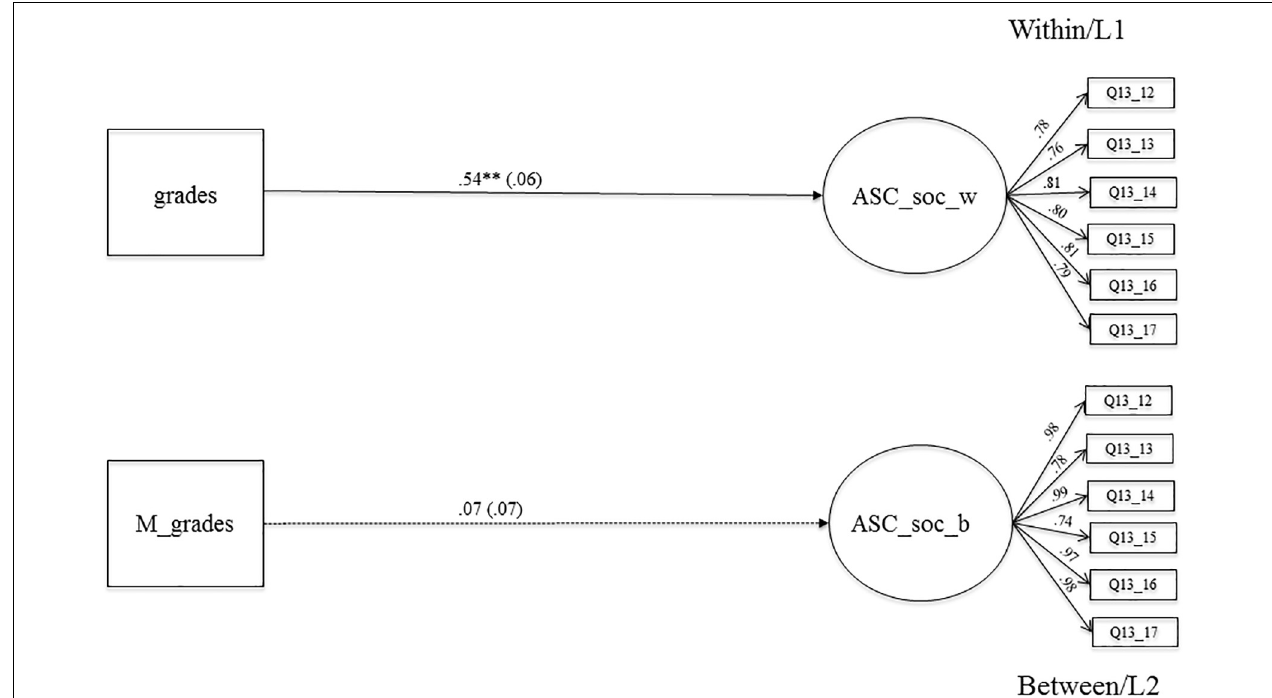
FIGURE 1 | The relationship between averaged grades in Math, German, English as a foreign language. Biology and social academic self-concept on the within and between level. Level 1, student level; Level 2, classroom level; regression coefficients were standardized by group-mean-centering; grades, averaged grades at the end of the school year 7 (Math, German, English as a foreign language, Biology); ASC_soc_w, social academic self-concept on LI (within); M_grades, aggregated mean-grades on L2; ASC_soc_b, social academic self-concept on L2 (between); bold pathways are significant at ∗ p < 0.05, ∗∗ p < 0.001; dotted pathways are not significant.